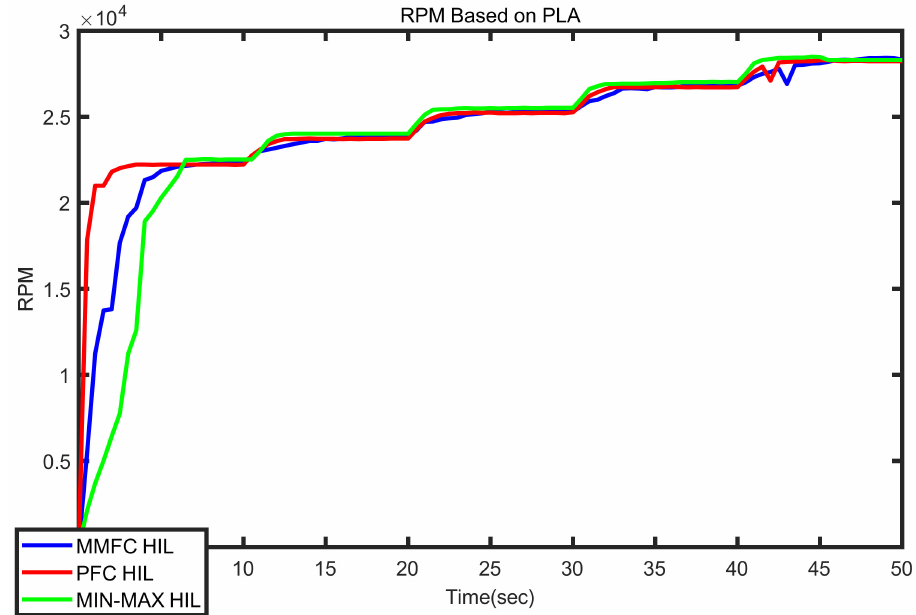
Figure 22. Command tracing comparison between PFC, MMFC and MIN–MAX controller in HIL test.